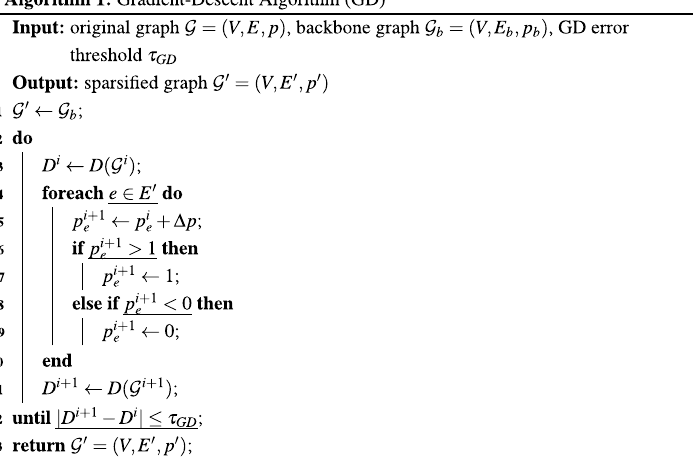
G ′ is dependent not only on the probability G b . The authors in